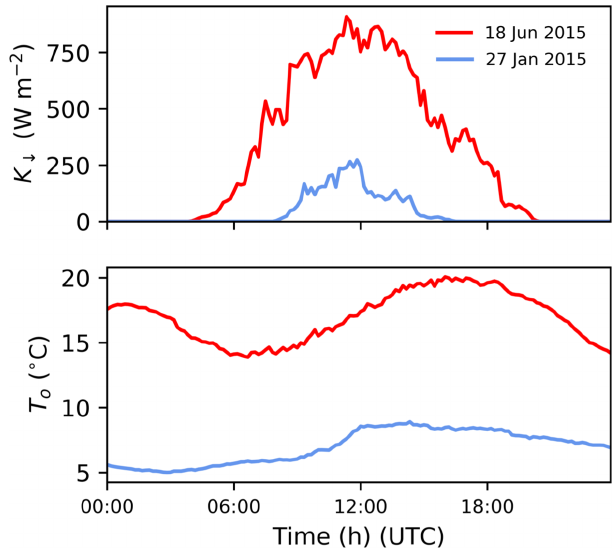
Figure 7. Incoming shortwave radiation ( K ↓ ; Wm − 2 ) and outdoor air temperature ( T o ; ◦ C) for 2 SW days. Observations (Table 5) are assumed to be constant across the domain in all runs (Table 6).